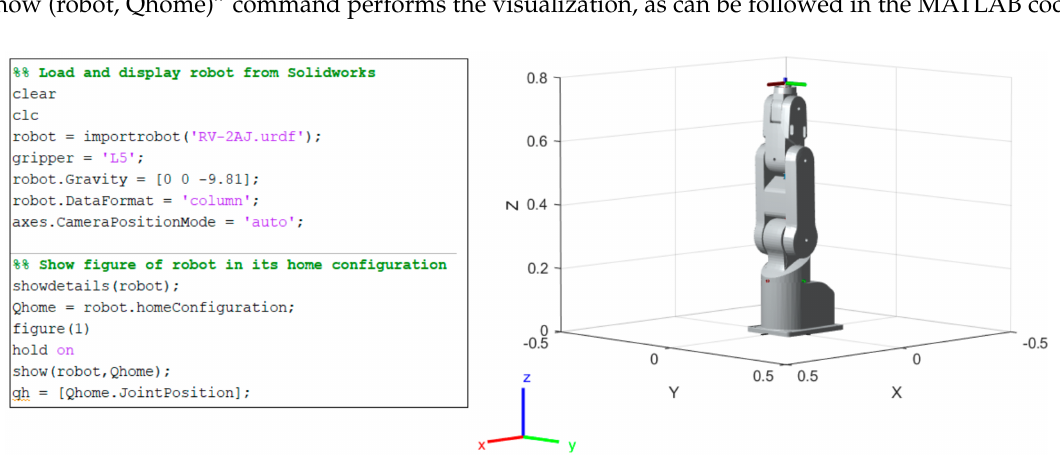
Figure 2. Visualization of RV-2AJ arm in the MATLAB environment.